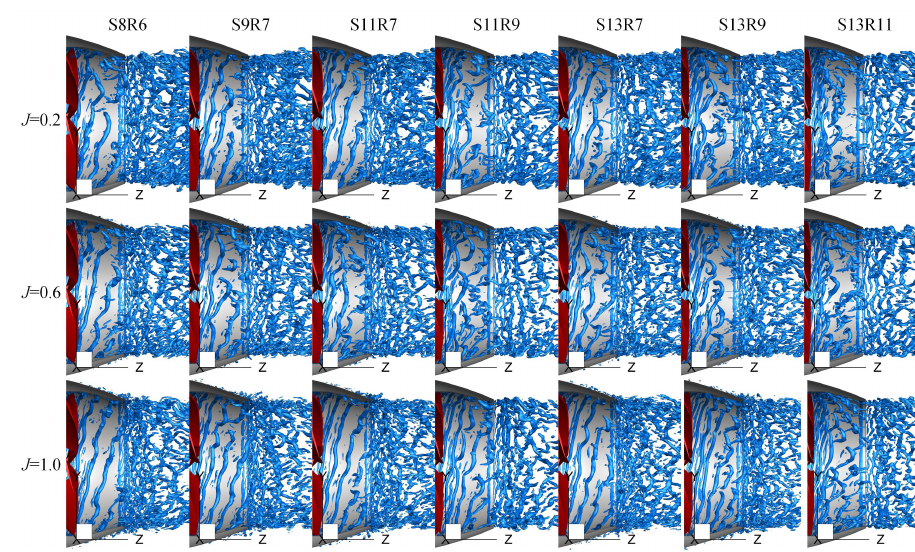
Figure 24. Interaction between the tip clearance leakage vortex and the duct shed vortex.